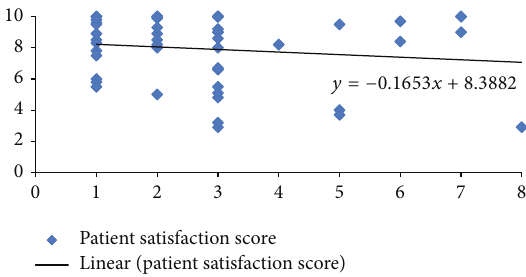
Figure 1: Plot of patient satisfaction score ( 𝑦 -axis) versus Frykman class ( 𝑥